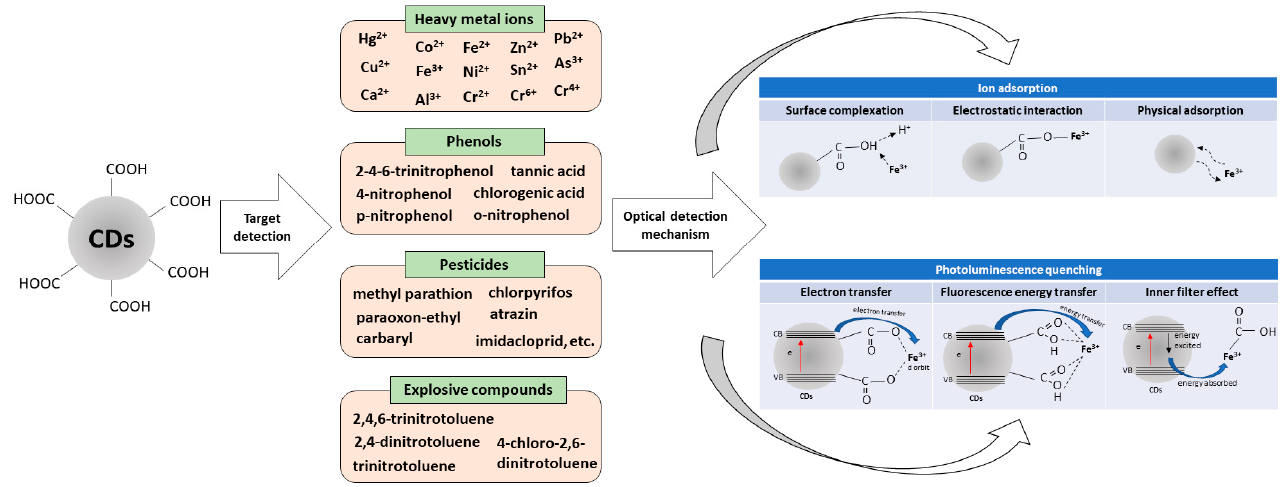
Figure 6. Schematic diagram of target detection and possible detection mechanism.